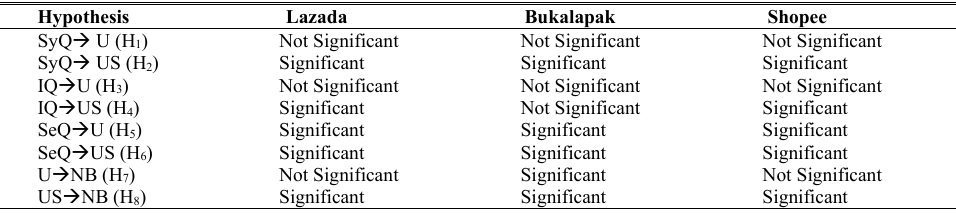
TABLE 3 COMPARISON OF E-COMMERCE SUCCESSFUL